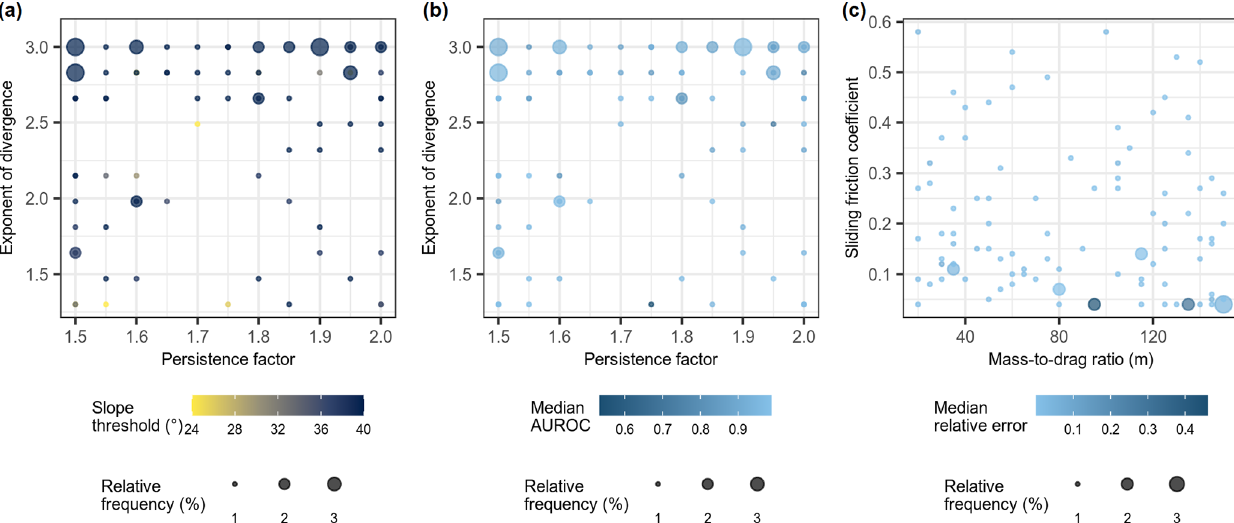
Figure 12. Performance and frequency of runout path (a, b) and distance (c) optimal parameters determined for individual debris flows. Relative frequency is the percentage of all repeated spatial-cross-validation iterations where a given parameter combination was